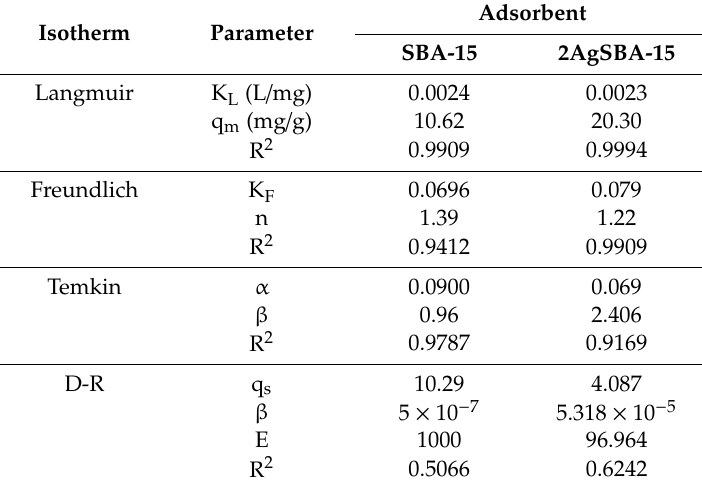
Figure 9. Nonlinear fittings of Langmuir, Freundlich, Temkin, and Dubinin–Radushkevich (D-R) equilibrium equations for sulfur adsorption over ( a ) SBA-15 and ( b ) 2AgSBA-15. Table 3. Fitting parameters for sulfur adsorption equilibrium data of SBA-15 and 2AgSBA-15 to Langmuir, Freundlich, Temkin, and Dubinin–Radushkevich (D-R)